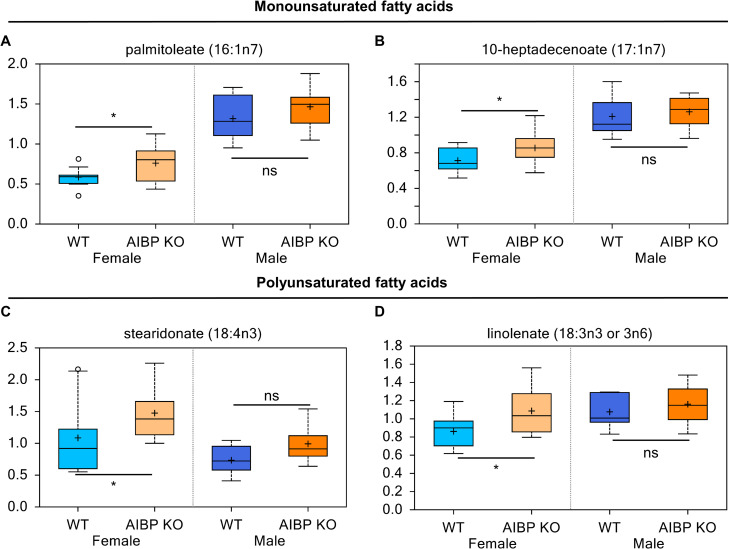
AIBP effect on mono- and polyunsaturated fatty acid metabolism.Changes of plasma content of monounsaturated fatty acids (A & B) and polyunsaturated fatty acids (C&D). *, p<0.05. ns: not significant (p>0.1).